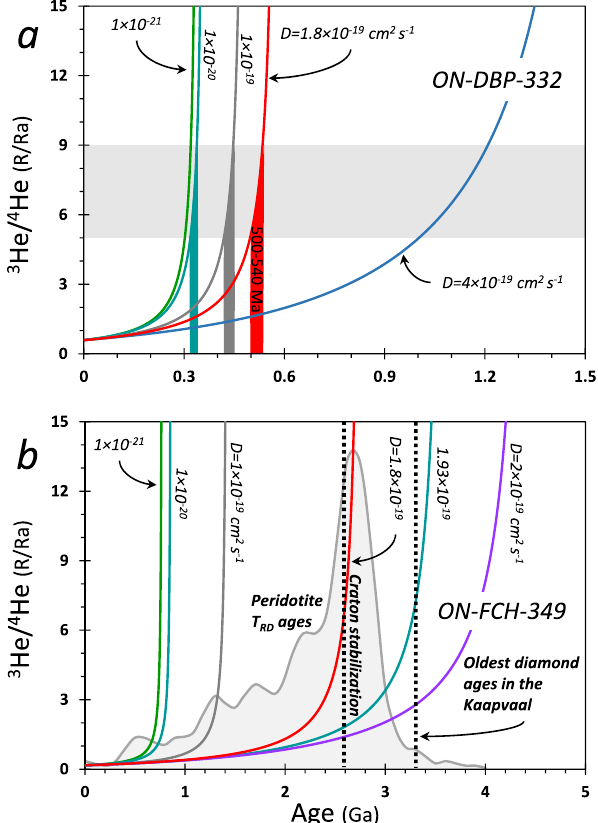
Fig. 5 Diffusion impact and constraints on diamond 3 He/ 4 He model ages. 3 He/ 4 He as a function of age and He diffusivity for a ON-DBP-332 (red diamond symbol in Fig. 2b) and b ON-FCH-349 (yellow circle in Fig. 2b), calculated based on the measured 3 He/ 4 He and the 4 He, 3 He, U, and Th concentrations in these diamonds, and assuming HDFs initial Ra values between 5 and 9 (gray horizontal shading in ( a ); representing common values for MORB, the CLM and subducted components). The 3 He/ 4 He model ages increase with increasing diffusivity. For ON-DBP-332 ( a ) the ages are between 320 – 340, 420 – 460, and 500 – 540 Ma (turquoise, gray, and red vertical shading, respectively). The potential range 3 He/ 4 He model ages for diamond ON-FCH-349 ( b ) can be constrained by considering the oldest diamond ages in the Kaapvaal craton 19,71 and the distribution of Kaapvaal peridotite Re-depletion ages 70 ( T RD model age; relative probability of n = 228; gray shading in b ). As HDF-bearing diamonds are unlikely to survive the thermal and tectonic history prior to craton stabilization at ~2.6 Ga 72 – 74 , this translates to a maximum diffusivity of He in HDF-bearing diamonds of <1.8 × 10 − 19 cm 2 s − 1 . Thus, the timing of diamond formation and CLM metasomatism based on (U-Th)/He dating of HDF-bearing diamonds is constrained to be between 3 He/ 4 He model ages for D = 1 × 10 − 21 and 1.8 × 10 − 19 cm 2 s − 1 . Additional details are given in the